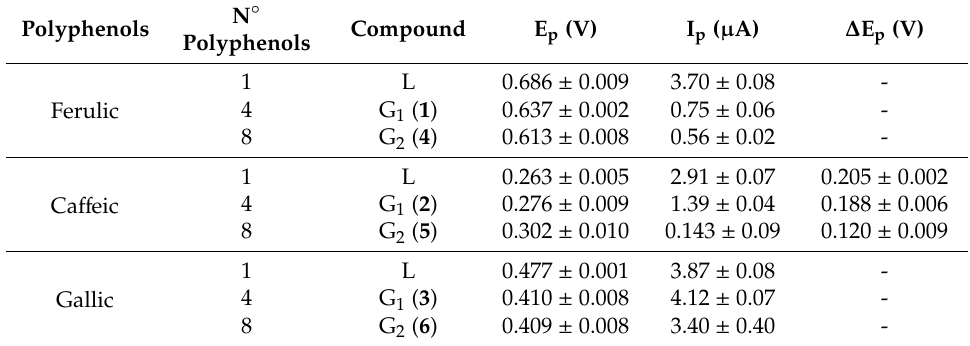
Table 1. Peak data extracted from the CVs of Figure 6. Error expressed as a standard deviation of three independent